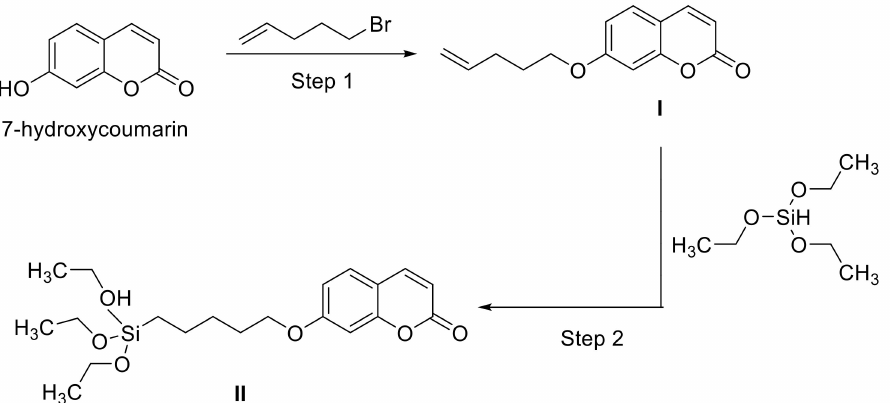
Figure 43. Synthesis of coumarin derivatives: I and II